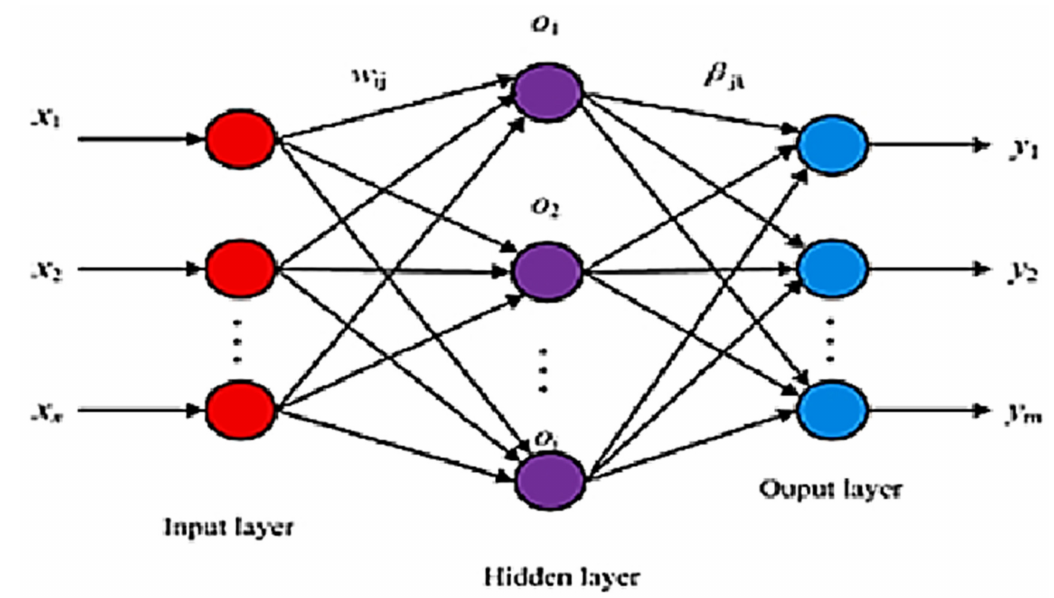
Figure 5. Architecture of Extreme Learning